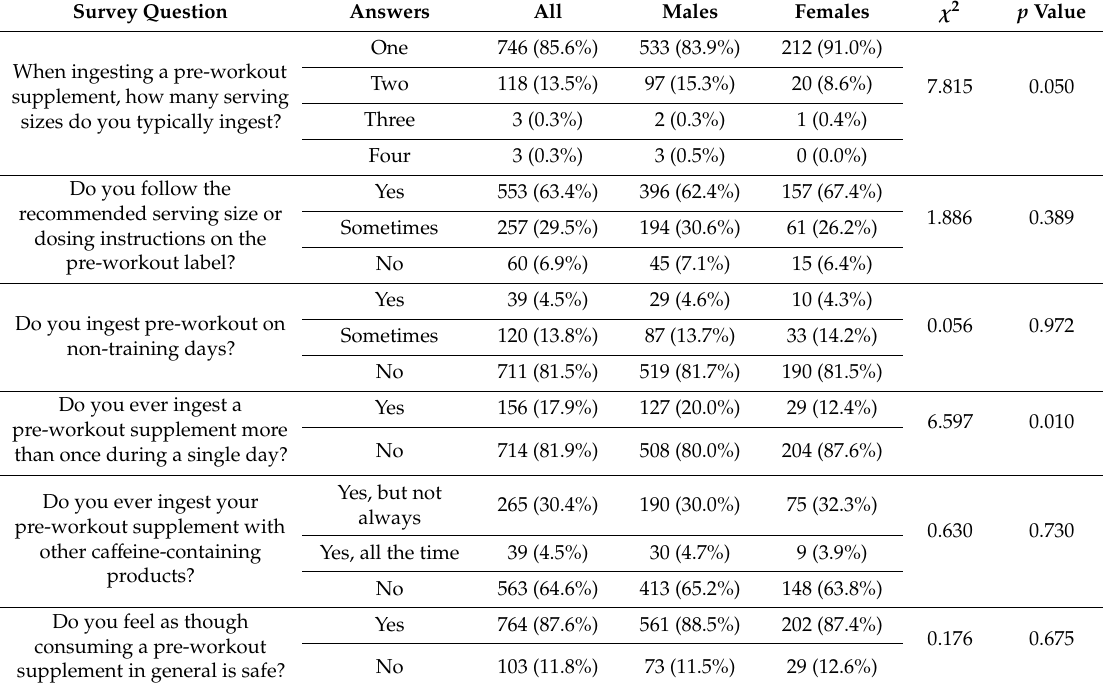
Table 1. Common practices of pre-workout supplement